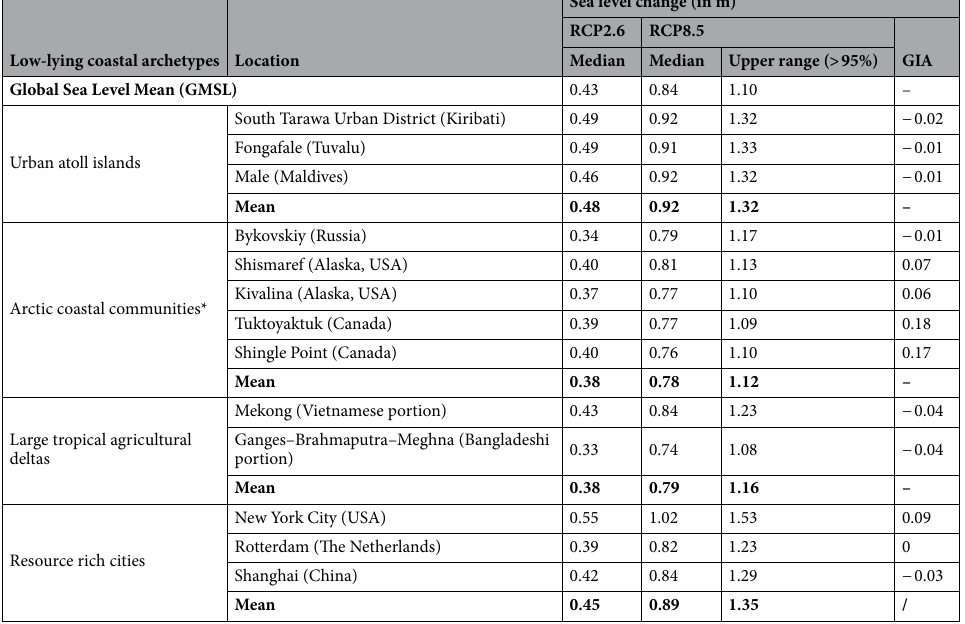
Table 1. Global mean and regional sea level rise (GMSL, RSL) by 2100 at the global scale and for the case studies used for the risk assessment. In the Arctic, only coastal communities (*) remote from regions of rapid glacial isostatic adjustment (GIA) have been considered. Anthropogenic subsidence is not included in these projections. Source: Ref. 17